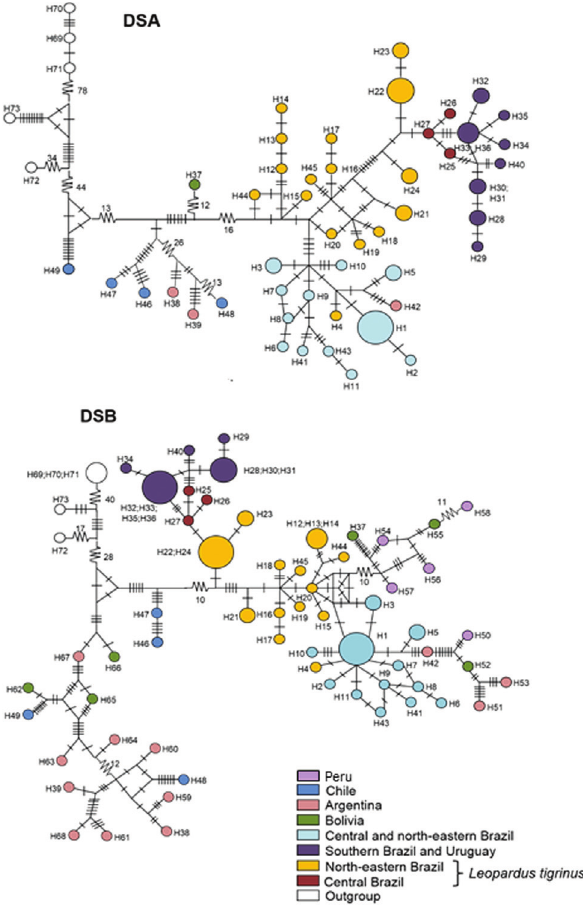
Figure 3 - Haplotype networks for mitochondrial DNA segments sampled in Leopardus colocola and L. tigrinus. The data consist of concatenated sequences from the mitochondrial ATP8 , Cytb, Control Region and ND5 segments. Haplotypes are represented by circles whose size is propor- tional to their frequency. Lines on branches indicate the number of muta- tional steps between haplotypes; differences larger than 10 mutational steps are indicated by numbers. The top panel depicts the results obtained with data set A (DSA), encompassing longer sequences; the bottom panel depicts results based on data set B (DSB), which incorporates additional, shorter sequences reported by Cossíos et al.